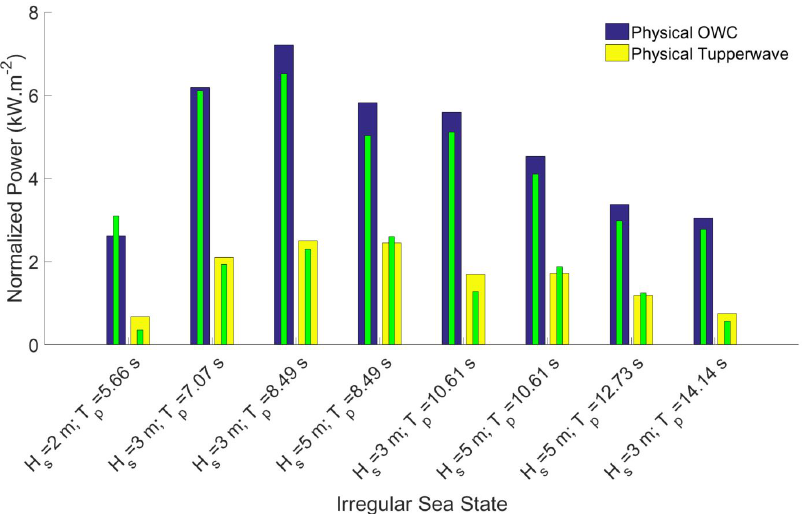
Figure 16. Average pneumatic power normalized by the significant wave height squared for the conventional OWC and the Tupperwave device in irregular sea